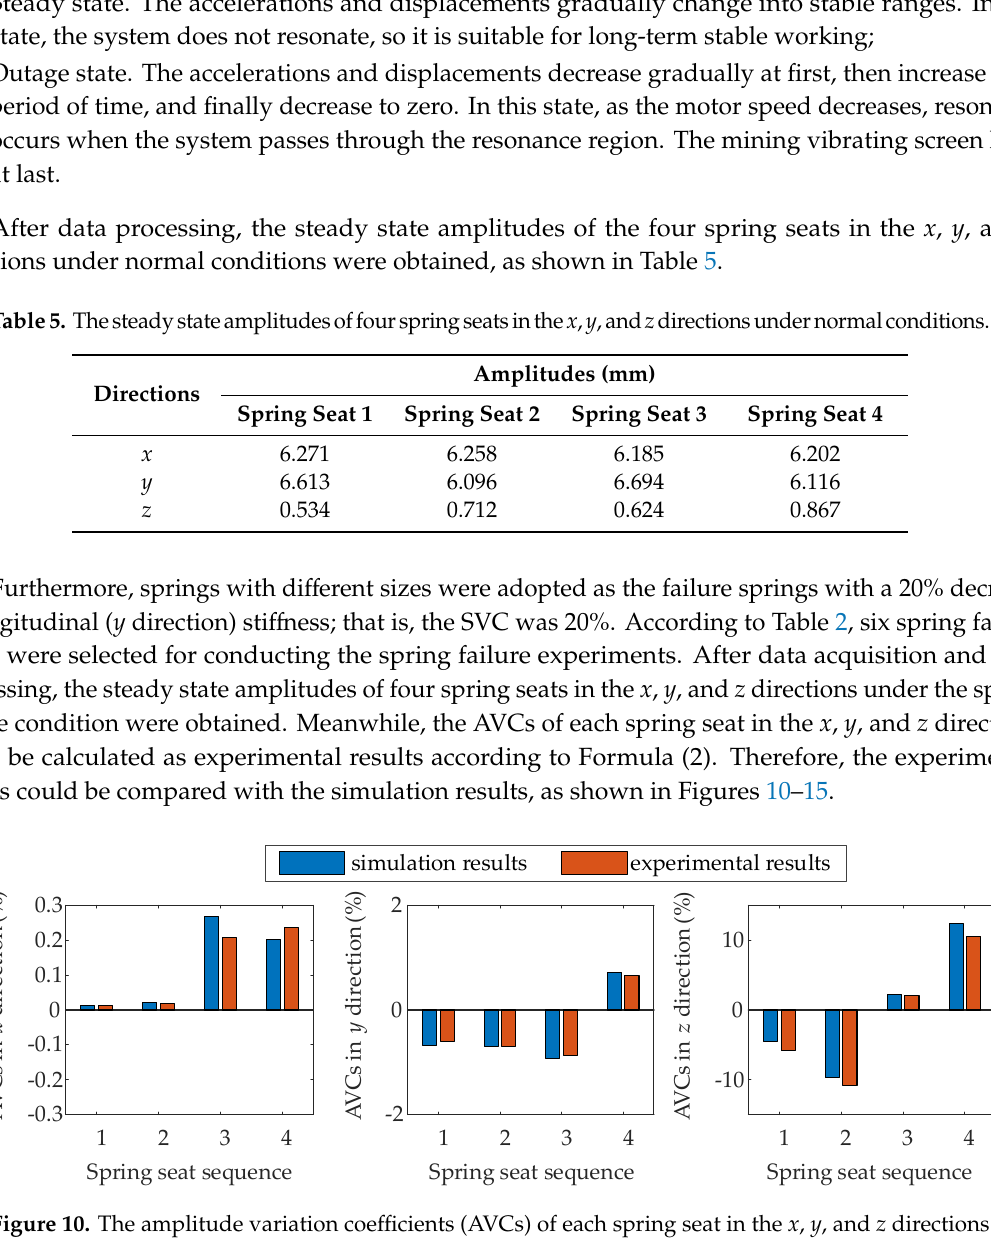
Figure 11. The amplitude variation coefficients (AVCs) of each spring seat in the x , y , and z directions under spring failure kind 2, including the simulation results and experimental results.